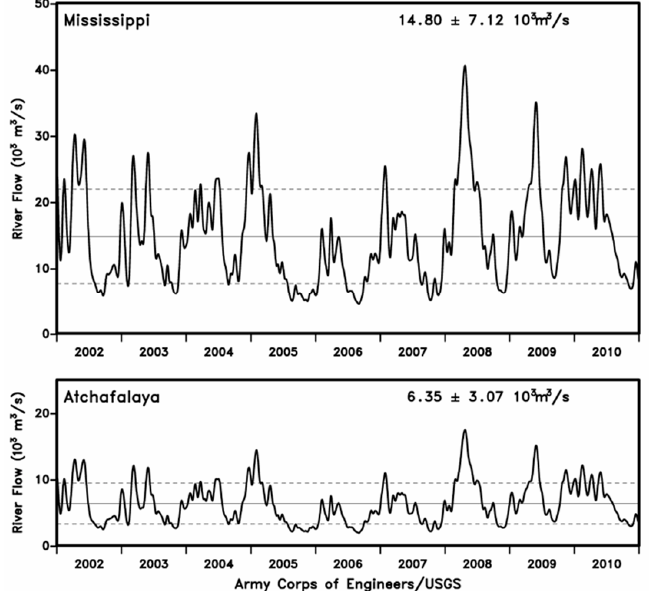
Figure 2. Real-time daily average river flows from Army Corps of Engineers for Mississippi River at Tarbert Landing, Mississippi, and for Atchafalaya River at Simmesport, Louisiana.